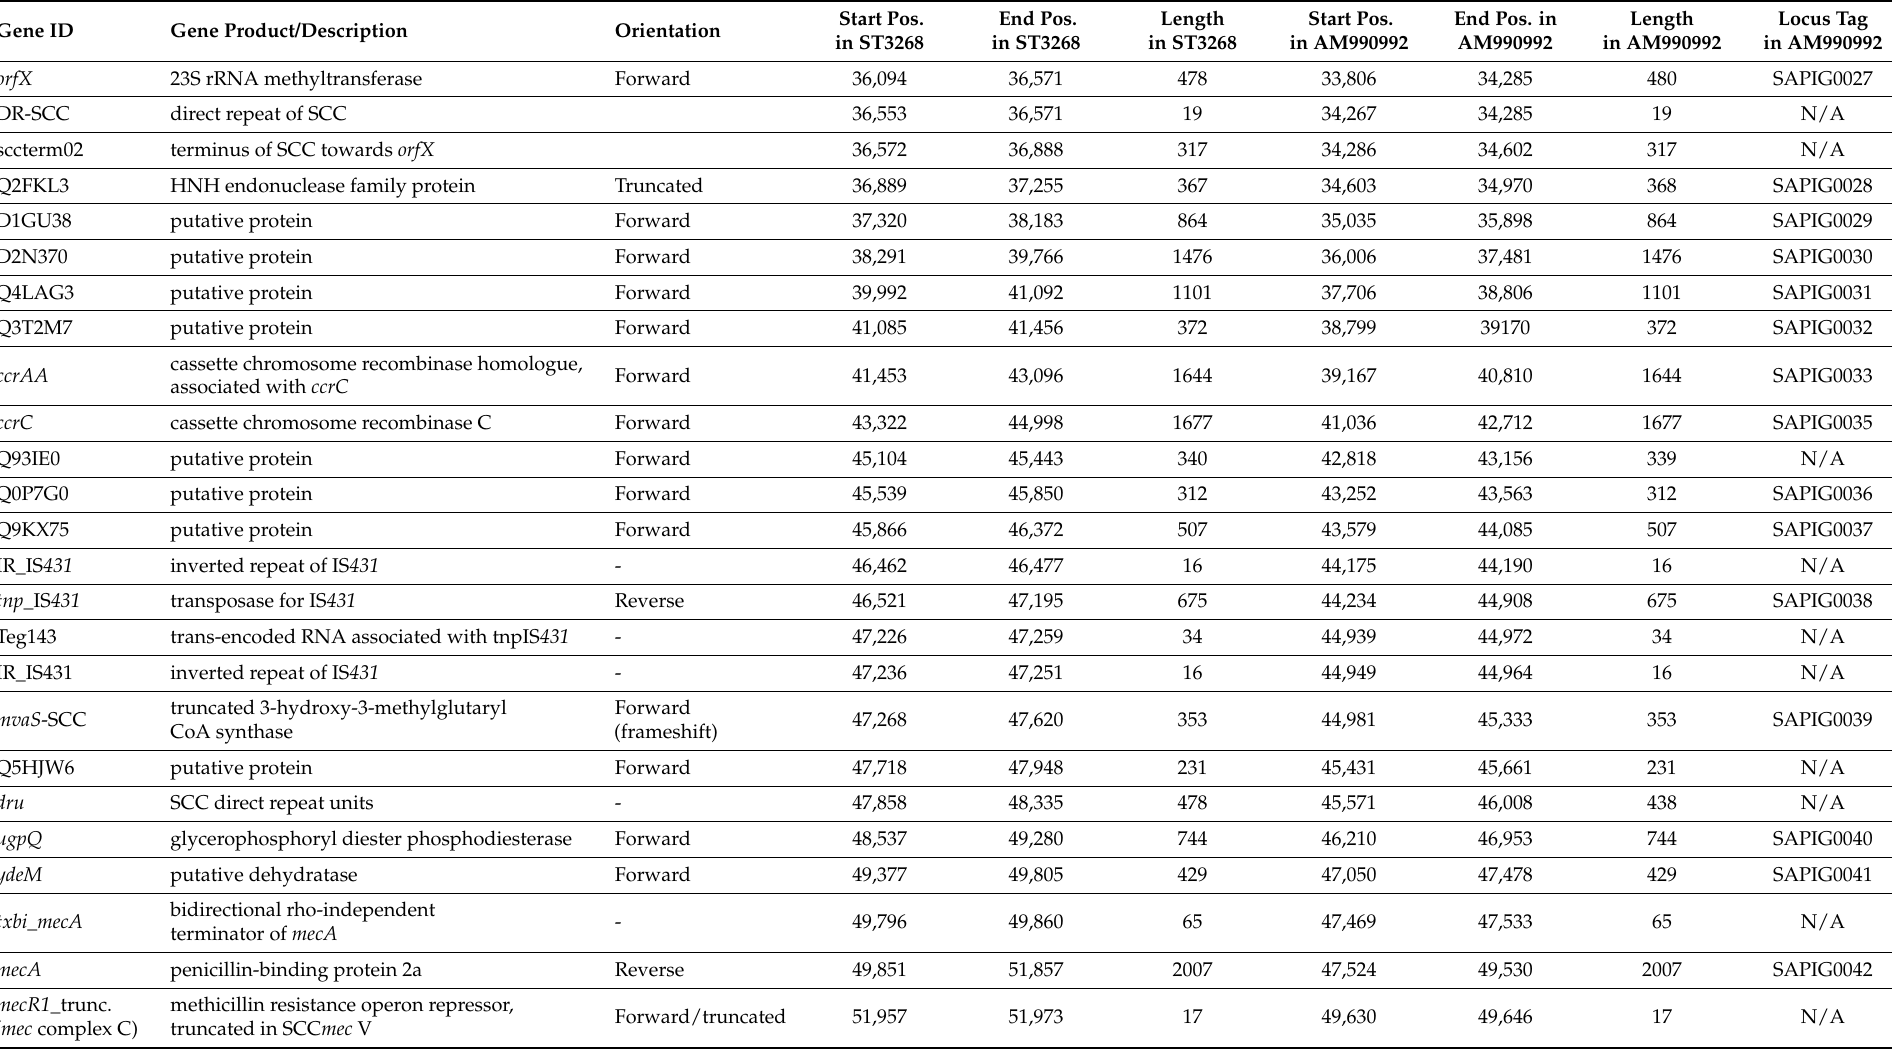
Table 5. The SCC mec element in ST3268-MRSA-VT compared to the one in the European CC398 LA-MRSA